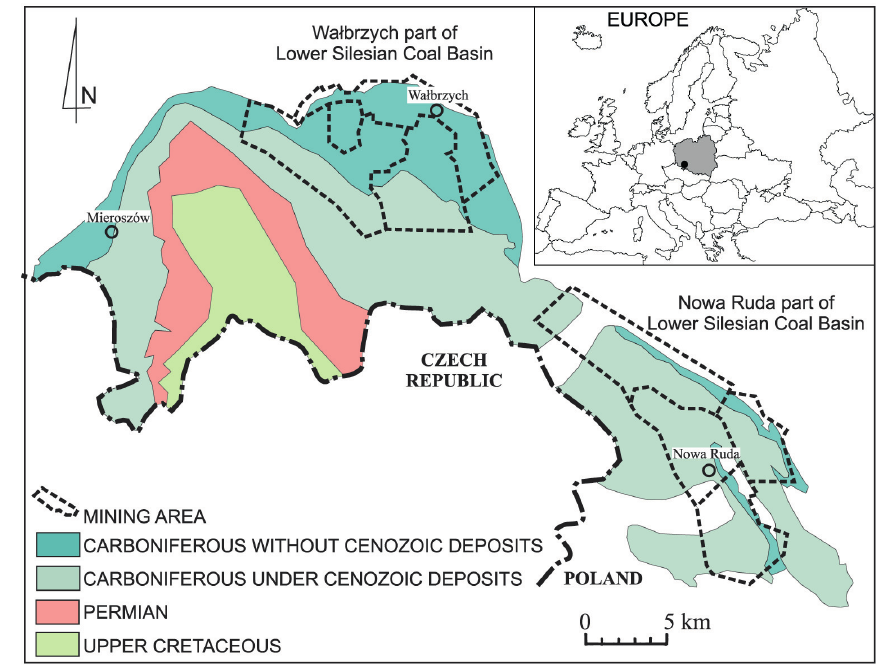
Figure 1. Location of the Lower Silesian Coal Basin on the background of Carboniferous